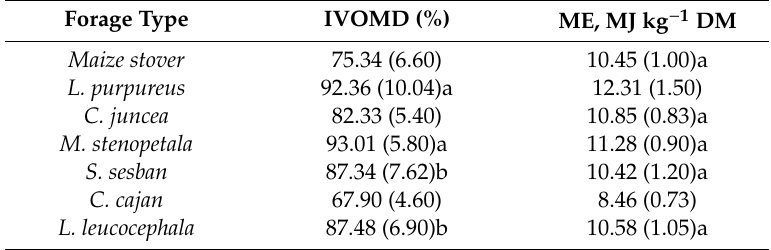
Table 3. In Vitro Organic Matter Digestibility (IVOMD) and Metabolizable Energy (ME) of test forages. Forage Type